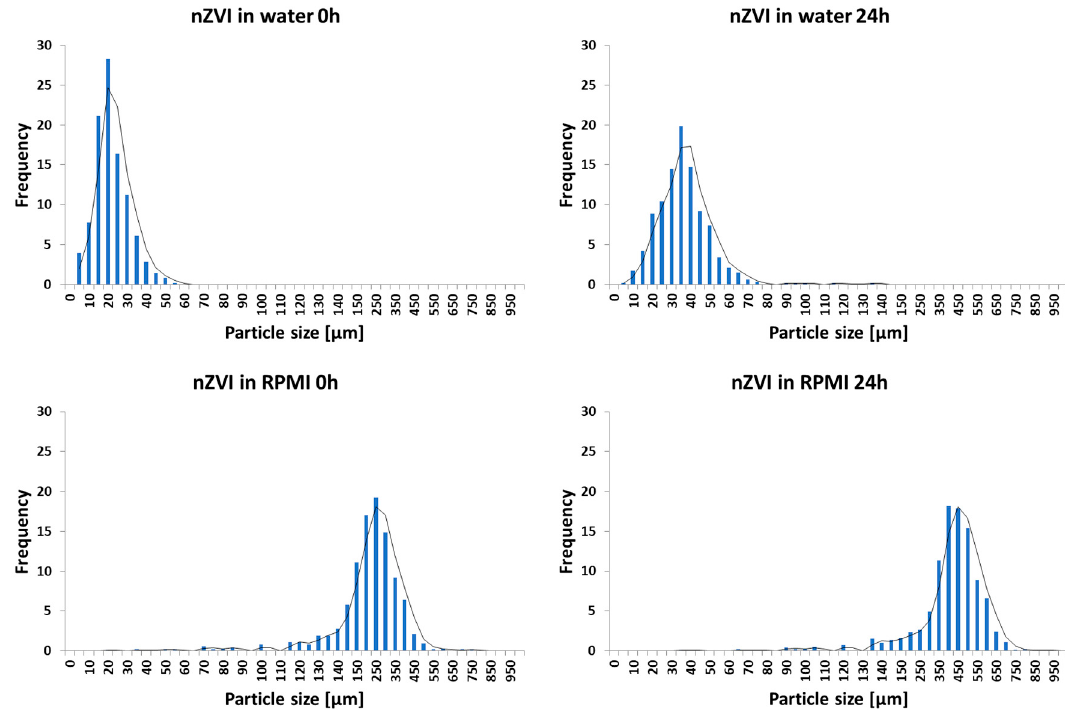
Figure 2. Particle size distribution of fresh and aged nZVI in distilled water and the exposure medium (RPMI 1640).